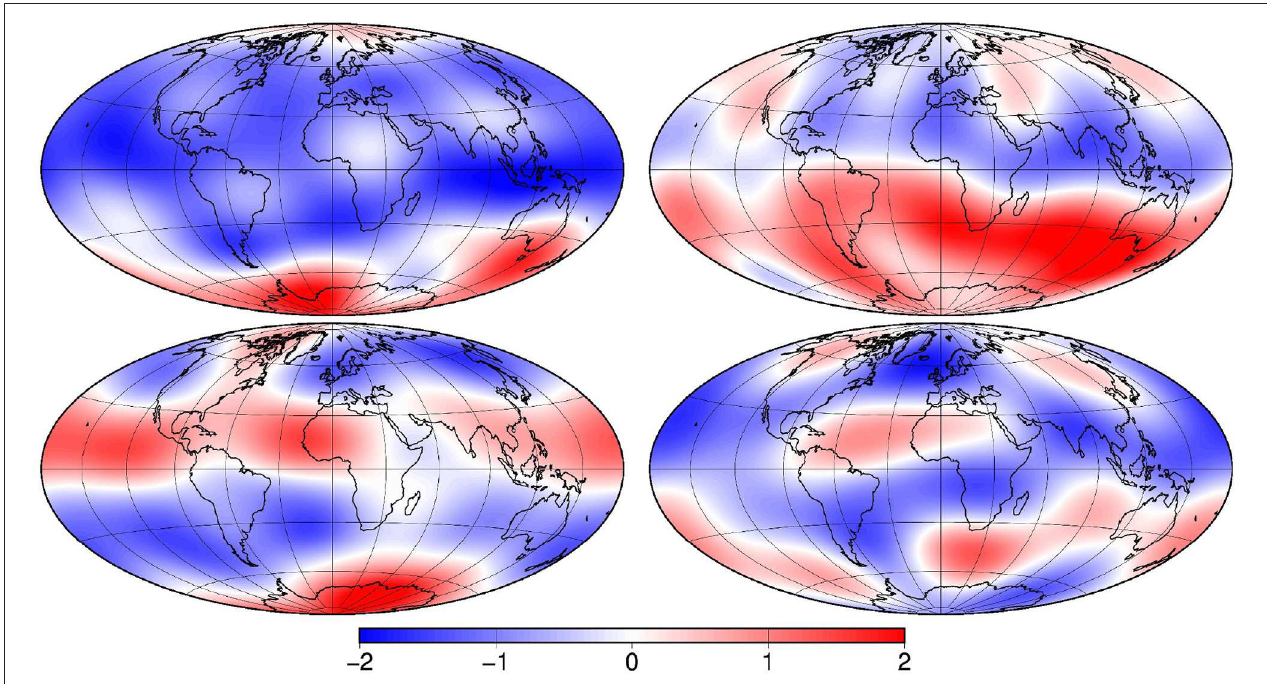
FIGURE 5 | Large-scale pattern of the 4 transformed vectors displayed in Figure 4